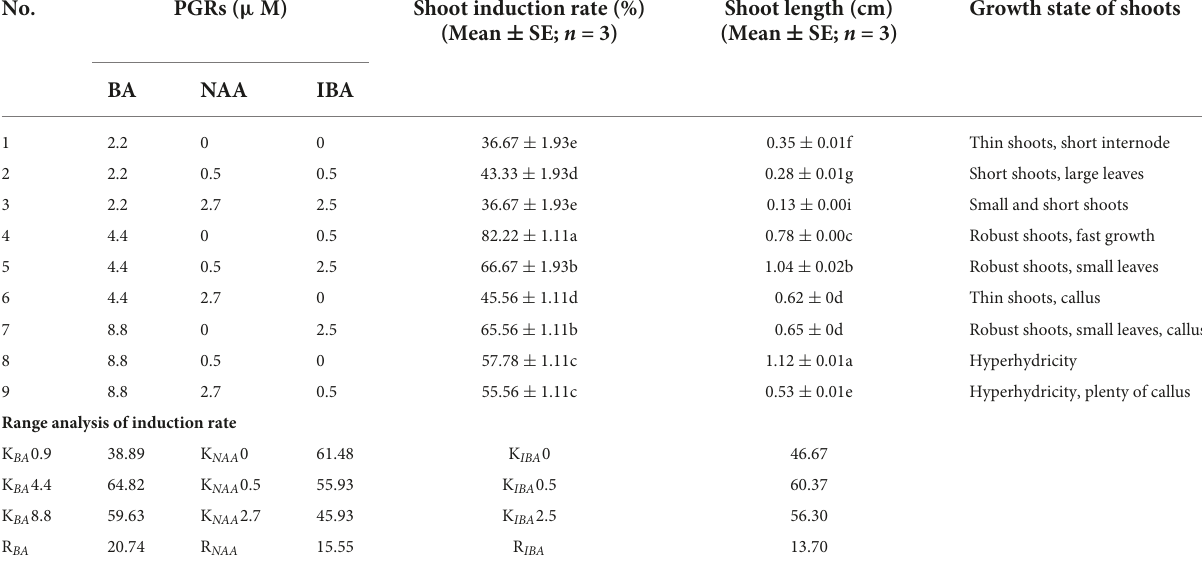
TABLE 3 Effects of different concentrations and compositions of BA, NAA, and IBA on shoot induction, and range analysis.